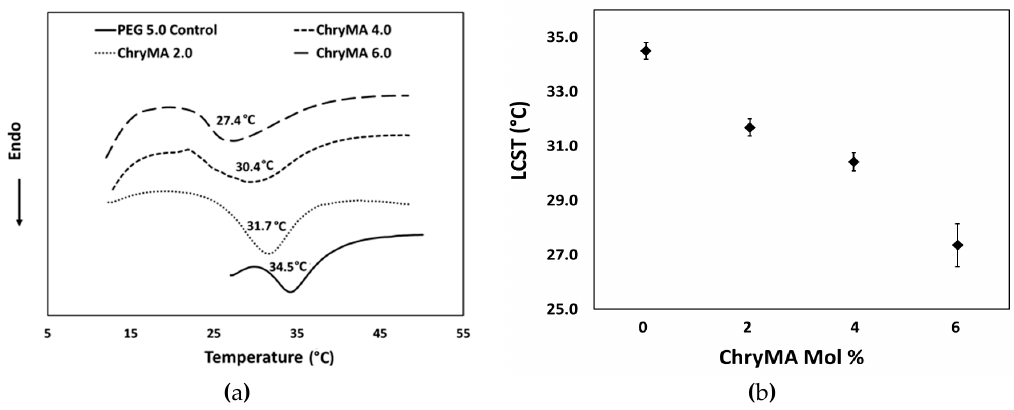
Figure 7. ( a ) Lower critical solution temperature (LCST) measurement of NIPAAm- co -ChryMA gels; ( b ) LCST as a function of ChryMA content.